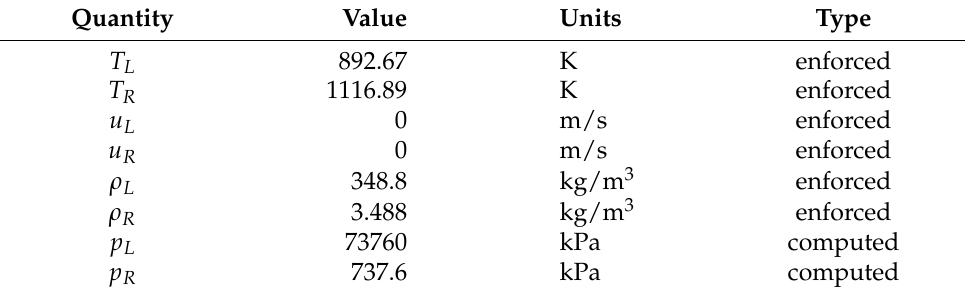
Figure 7. Double symmetric expansion. Single species: air. Ideal EoS. Initial conditions listed in Table 3. First order Godunov. One thousand cells. Table 4. Real gas transonic Sod problem initial